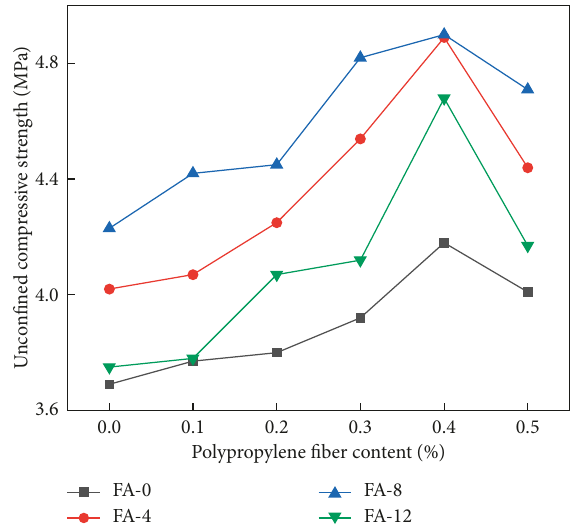
Figure 5: Relationship between unconfined compressive strength and polypropylene fiber